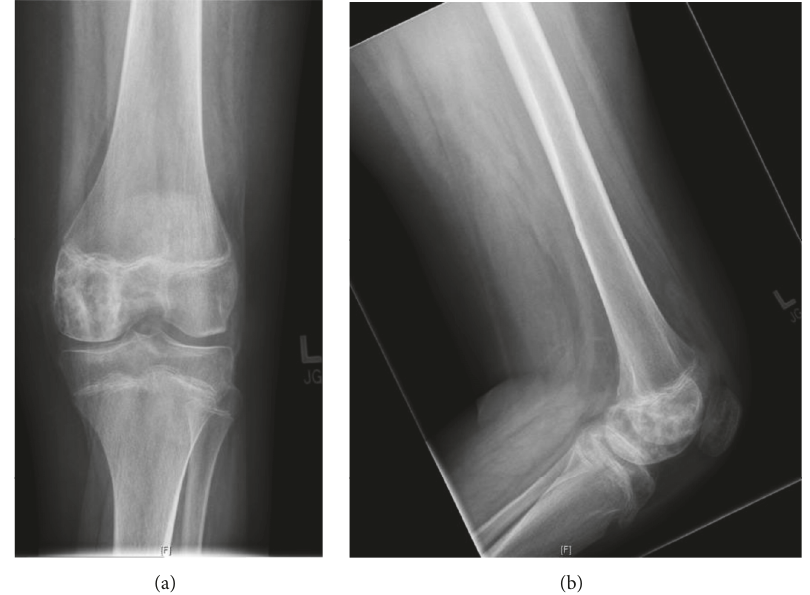
Figure 5: Anteroposterior (a) and lateral radiographs (b) of the left knee after core biopsy, September 2009.